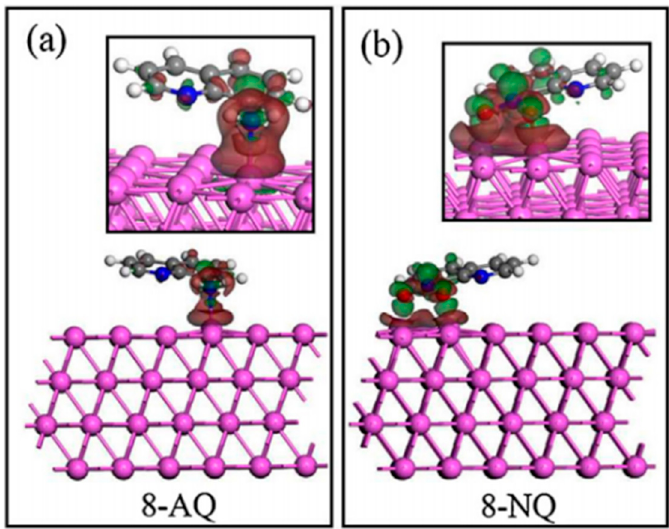
Figure 5. Charge density difference of inhibitor molecules absorbed onto Al(1 1 1): ( a ) 8-AQ; ( b ) 8- NQ [59].